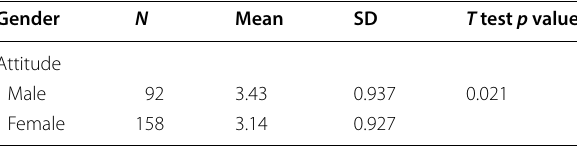
Table 6 Effects of gender on readiness for internship after urology rotation Gender N Mean